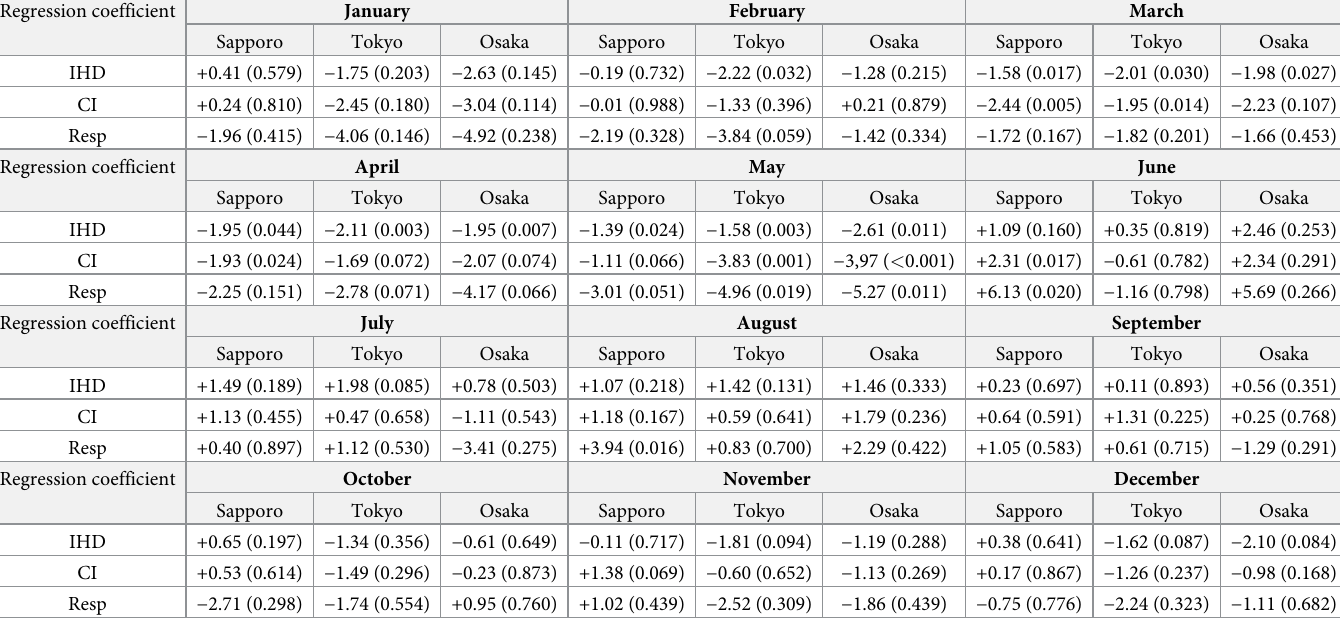
Table 1. Regression results of MR adj to MMT obtained from the pre-COVID-19 pandemic years (2010–2019). The results of acute ischemic heart disease (IHD), cere- bral infarction (CI), and respiratory diseases (Resp) in each month. Parentheses indicate the p -value with a t-test for a regression coefficient at the 90%, 95%, and 99% lev- els,